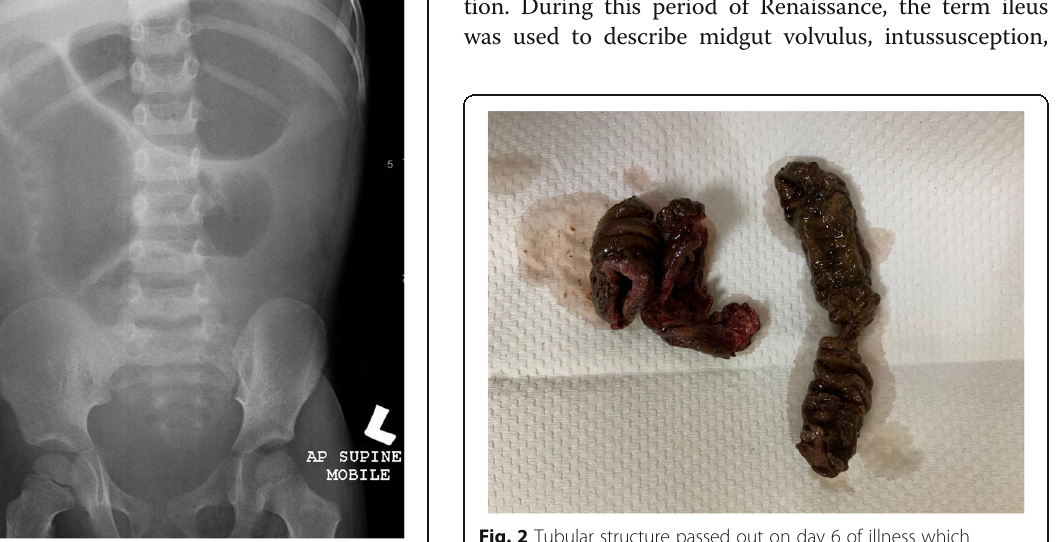
Fig. 1 Abdominal X-ray which showed dilated small bowel loops